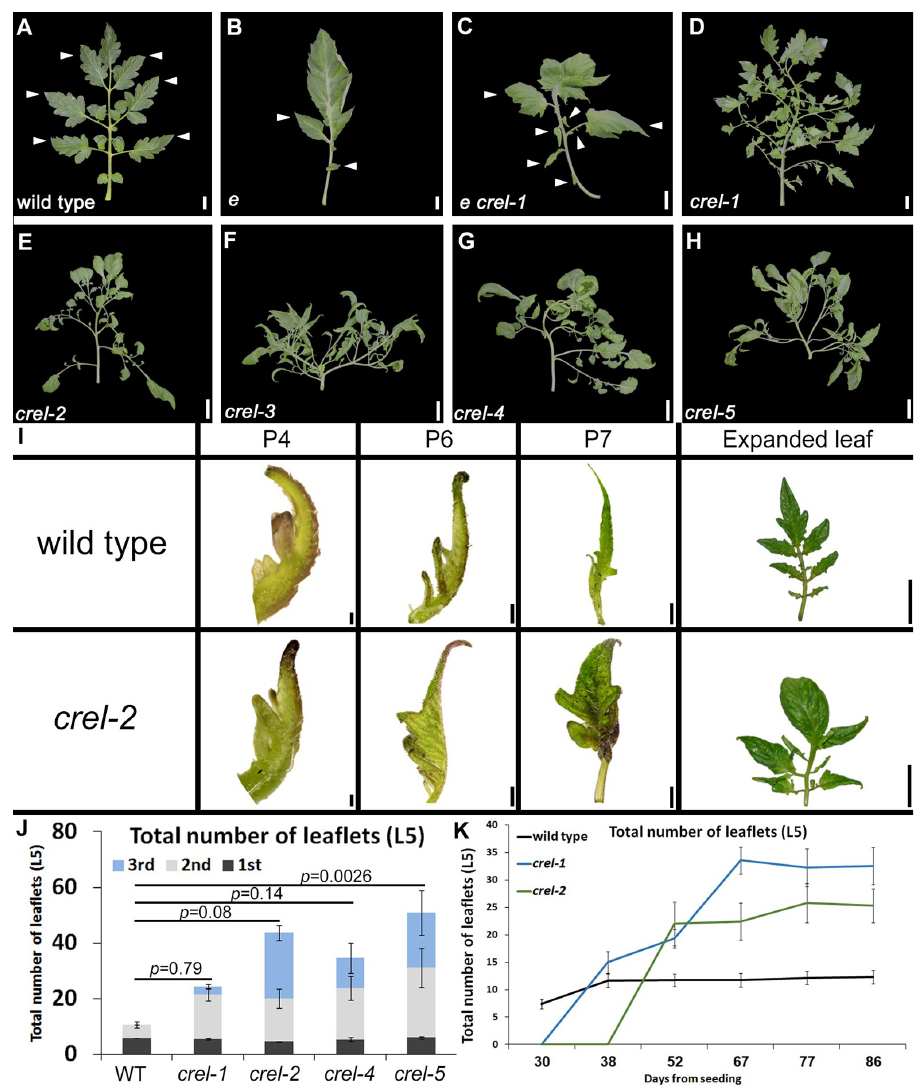
Fig 1. Mutating crel suppresses the e simple leaf phenotype and produces very compound leaves. (A-H) Mature 5 th leaves of the indicated genotypes. A-C suppression of e by crel-1 ; D-H: leaves of 5 different crel alleles. Scale bars: 2cm. (I) Early leaf development in the fifth leaf of wild type and crel-2 . P4- P7 designate the developmental stages, where P4 is the forth youngest leaf primordium. Scale bars: 0.1 mm (P4), 0.5 mm (P6), 2 mm (P7), 2 cm (expanded leaf). (J) Quantification of the number of leaflets in a mature 5 th leaf of the indicated crel alleles, compared to the wild type. 1 st , 2nd and 3 rd represent primary, secondary and tertiary leaflets, respectivley, where primary leaflets arise from the rachis, secondary leaflets arise from primary leaflets etc. (K) Leaflet production over time by the fifth leaf) L5) of the indicated genotypes.